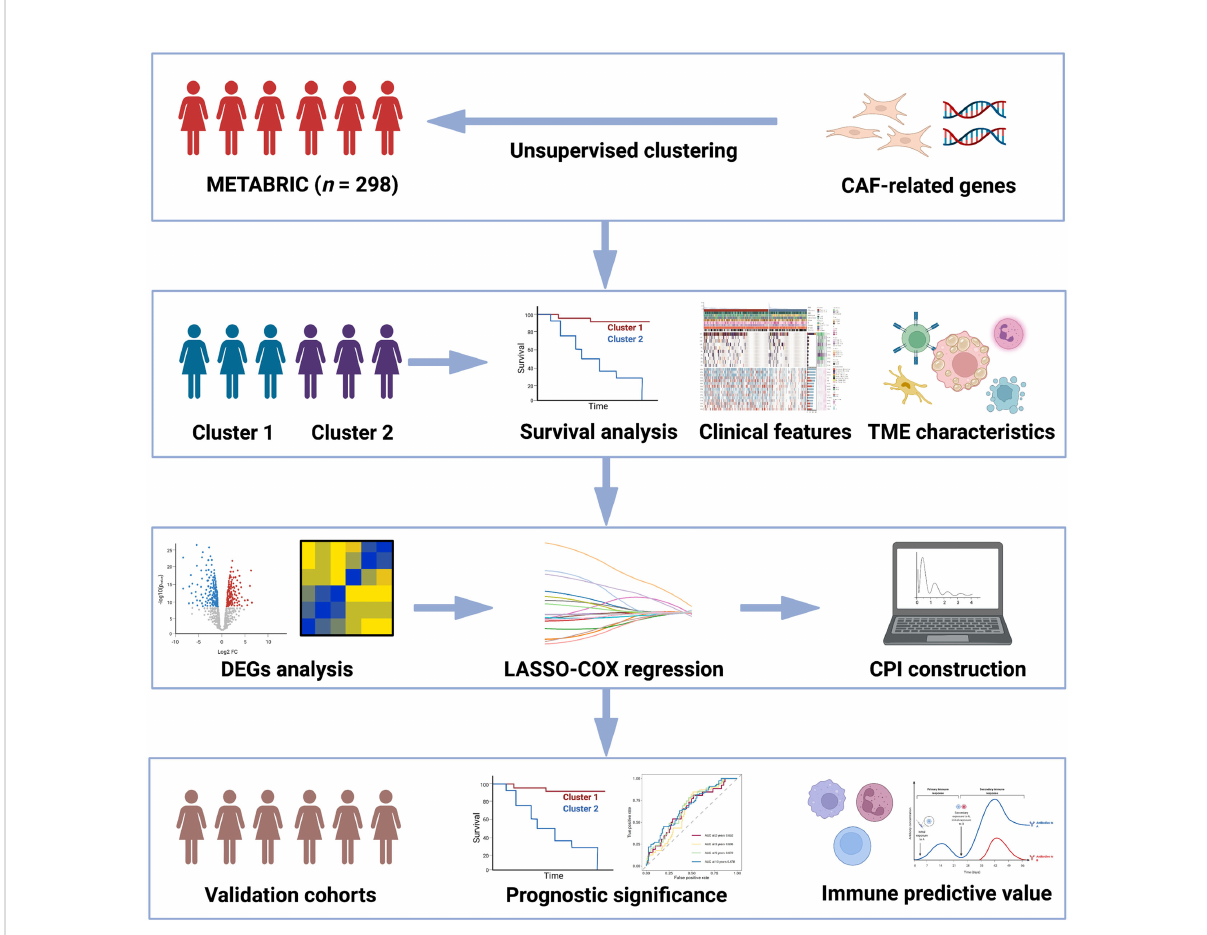
FIGURE 1 Flowchart for comprehensive analysis of the new CAF-related pattern in